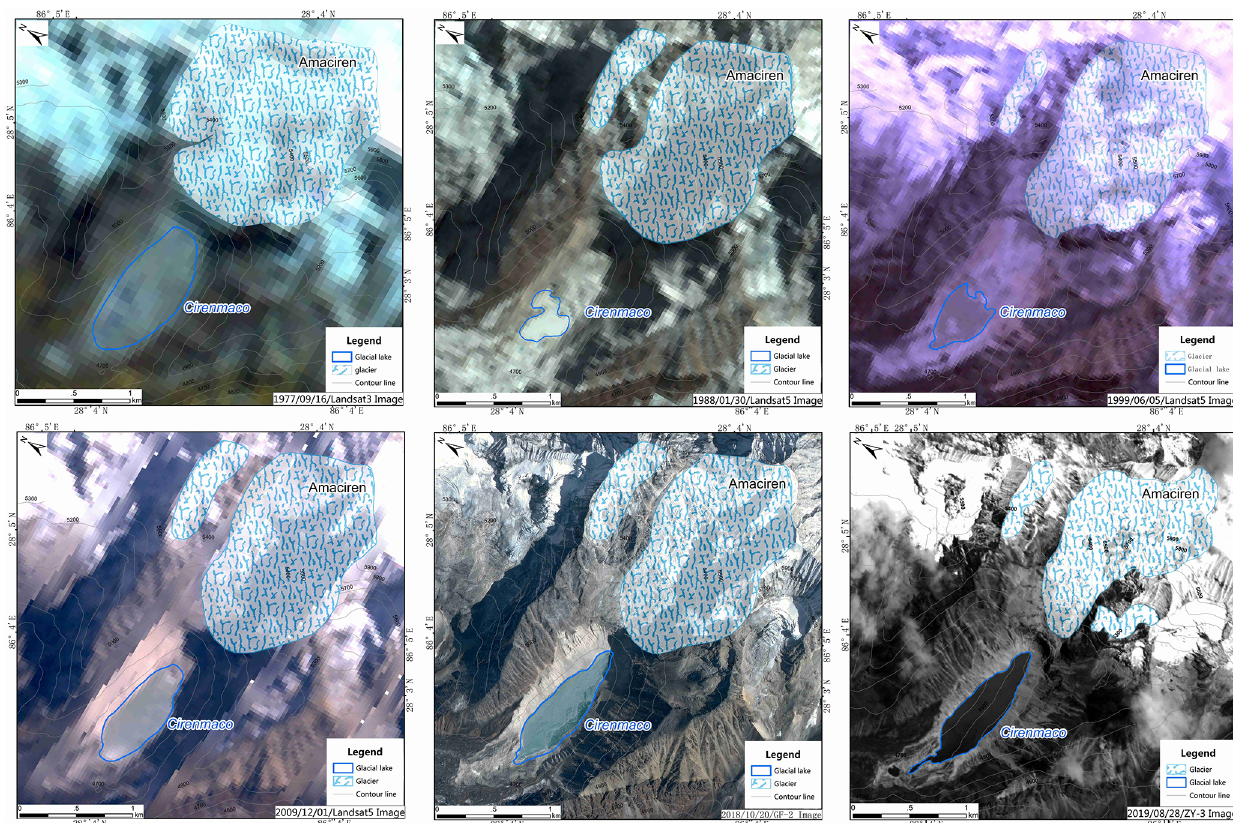
Figure 4. A comparison of the area change between the Cirenmaco Lake and its connected glacier. Table 7. Basic parameters for major glacial lakes in the Poiqu River basin. Major lakes Tributaries Water Connected Distance Water supply glacier